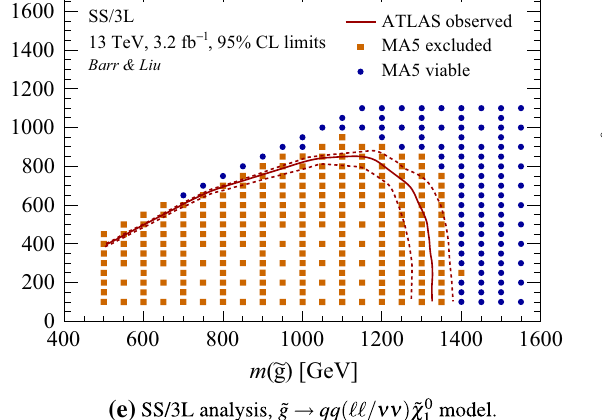
Fig. 14 Comparison of representative simplified model limits repro- duced by our MadAnalysis implementation and those published by ATLAS for each analysis considered (Table 1). The red solid line is the 95% confidence level limit observed by ATLAS with the dashed lines either side indicating the reported one standard deviation theoretical